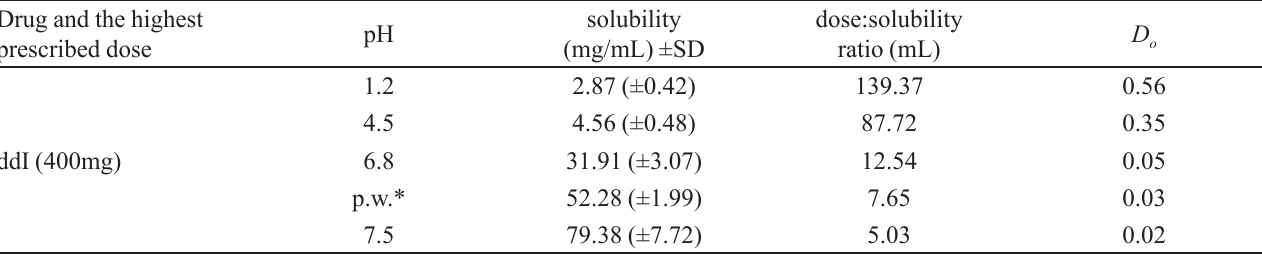
TABLE I - Solubility results and their standard deviation (SD) values at 37 °C and dose:solubility ratio of ddI for each buffer media used for the equilibrium method assay Drug and the highest prescribed dose